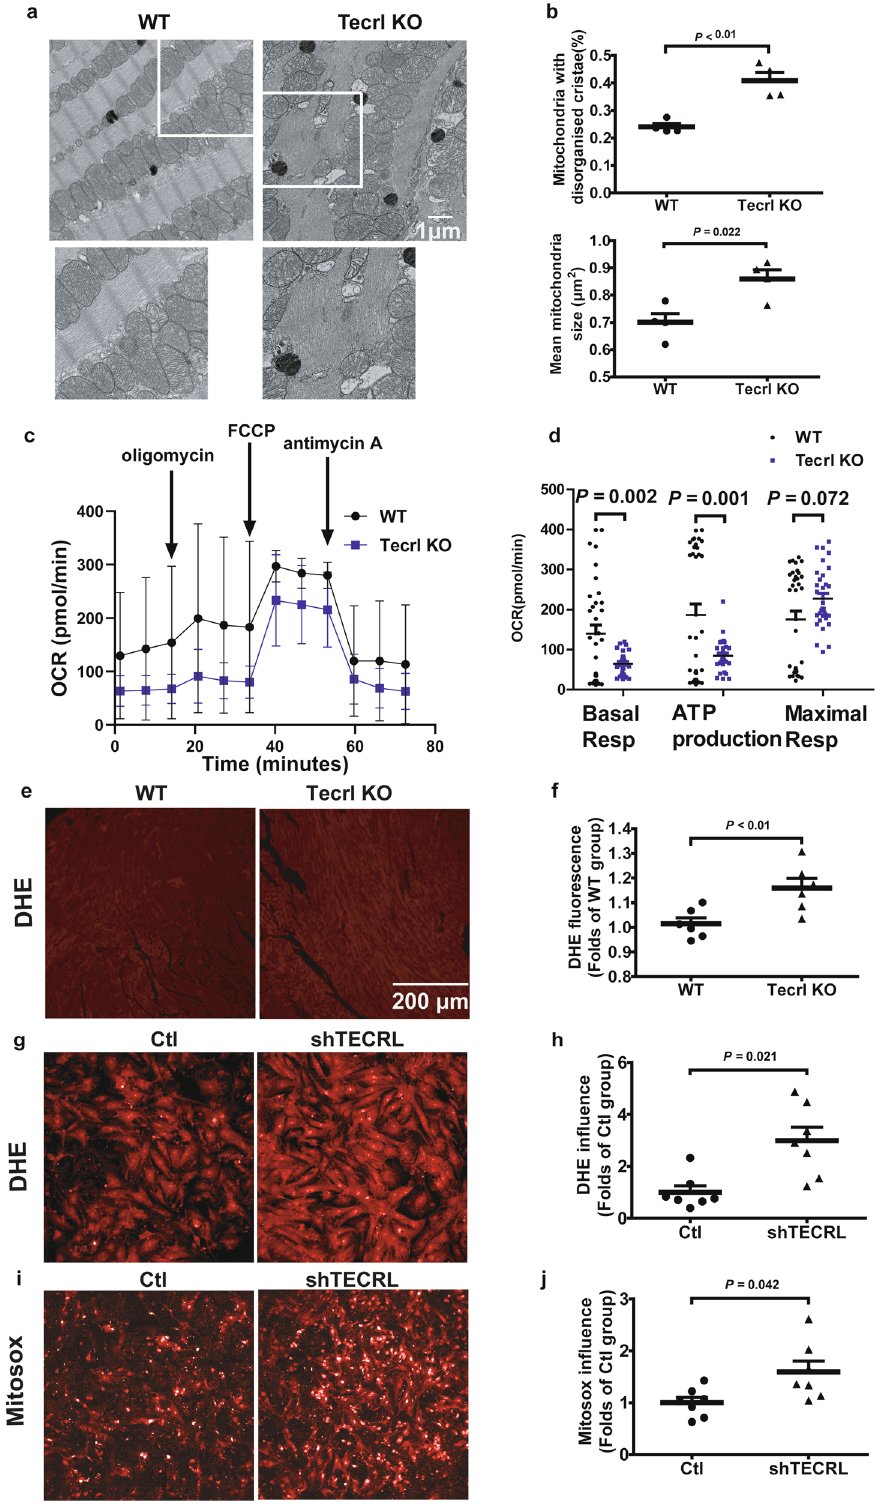
Fig. 4 Tecrl de fi ciency signi fi cantly suppressed mitochondrial respiration. a , b The cardiac ultrastructure of the mice was examined by TEM. Representative image and quantitative analysis of cardiac ultrastructure of the WT and Tecrl KO mice at the age of 8 weeks. Magni fi cation is 6700 x, scale bar = 1 μ m ( n = 4). c , d Measurements of OCR and respective quantitative analysis of cardiomyocytes isolated from WT and Tecrl KO mice (WT, n = 34, Tecrl KO, n = 32). e , f Representative image and quantitative analysis of DHE staining. The WT and Tecrl KO mice tissues were both measured at the age of 8 weeks ( n = 6). g , h Representative image and quantitative analysis of DHE staining in primary neonatal cardiomyocytes ( n = 7). i , j Representative image and quantitative analysis of Mitosox staining in primary neonatal cardiomyocytes ( n = 4). FCCP, tri fl uoromethoxy carbonyl cyanide phenylhydrazone. Values are mean ± SE. P < 0.05 was considered signi fi